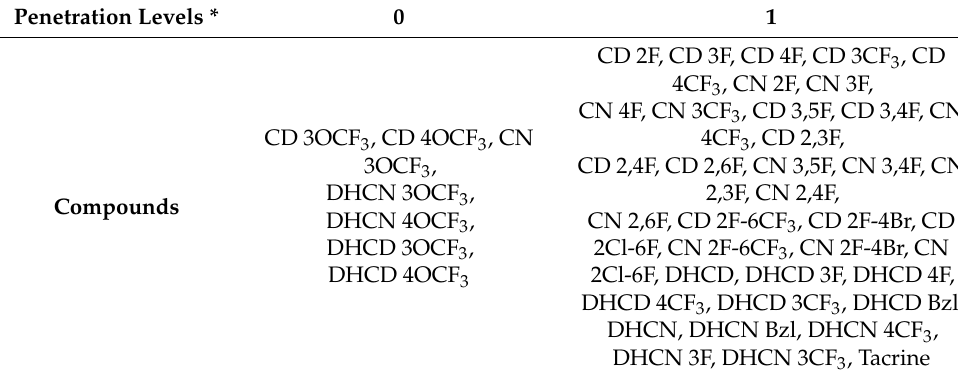
Table 6. In silico determined prediction of passive transport of compounds to the central nervous system (CNS) through the BBB, according to BIOVIA ADMET Protocol.